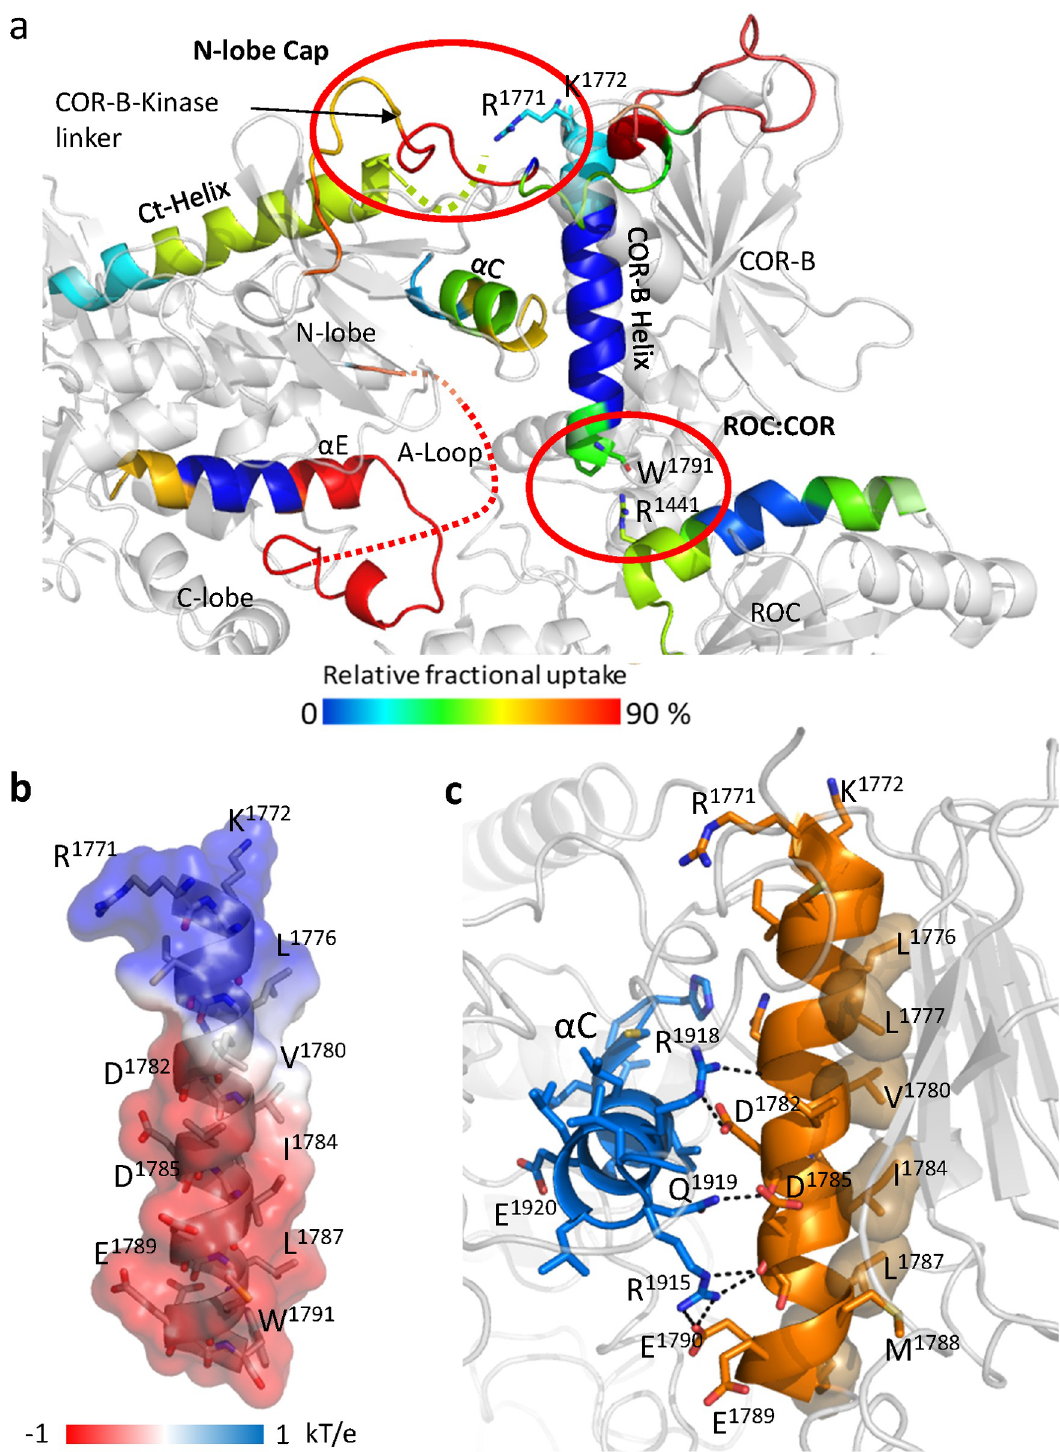
Fig 3. Characterization of COR-B Helix. (a) The COR-B Helix, the α C helix and Ct-Helix, and the ROC domain that near the C- terminal end of the COR-B Helix are colored based on the relative fractional uptake (PDB: 6VNO). (b) The surface electrostatic potential of the COR-B Helix. The positively charged N-terminal end of the COR-B Helix is interacting with the Ct-Helix, while the C-terminal end is negatively charged and interacts with the ROC domain. (c) All hydrophobic residues of the COR-B Helix are located on the same side and buried in the COR-B domain, while the charged residues that are forming multiple salt bridges with the α C helix are located on the other side. A-loop, activation loop; Ct-Helix, C-terminal helix; ROC, ras-of-complex. https://doi.org/10.1371/journal.pbio.3001427.g003 PLOS Biology | https://doi.org/10.1371/journal.pbio.3001427 February 22,